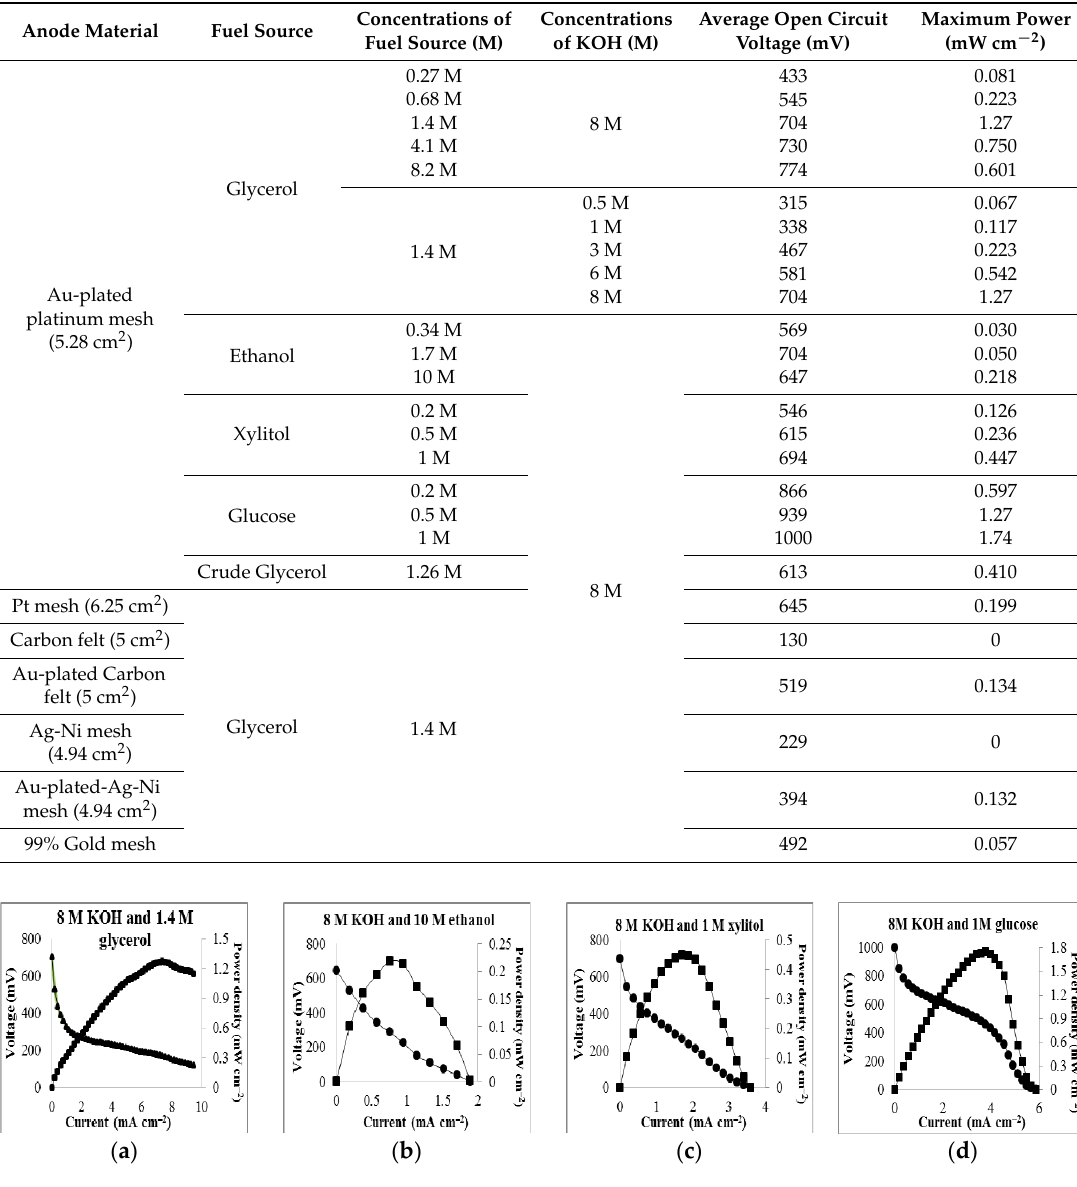
Table 1. Various combinations of electrolyte solutions with different anodic surfaces and their corresponding average power outputs.